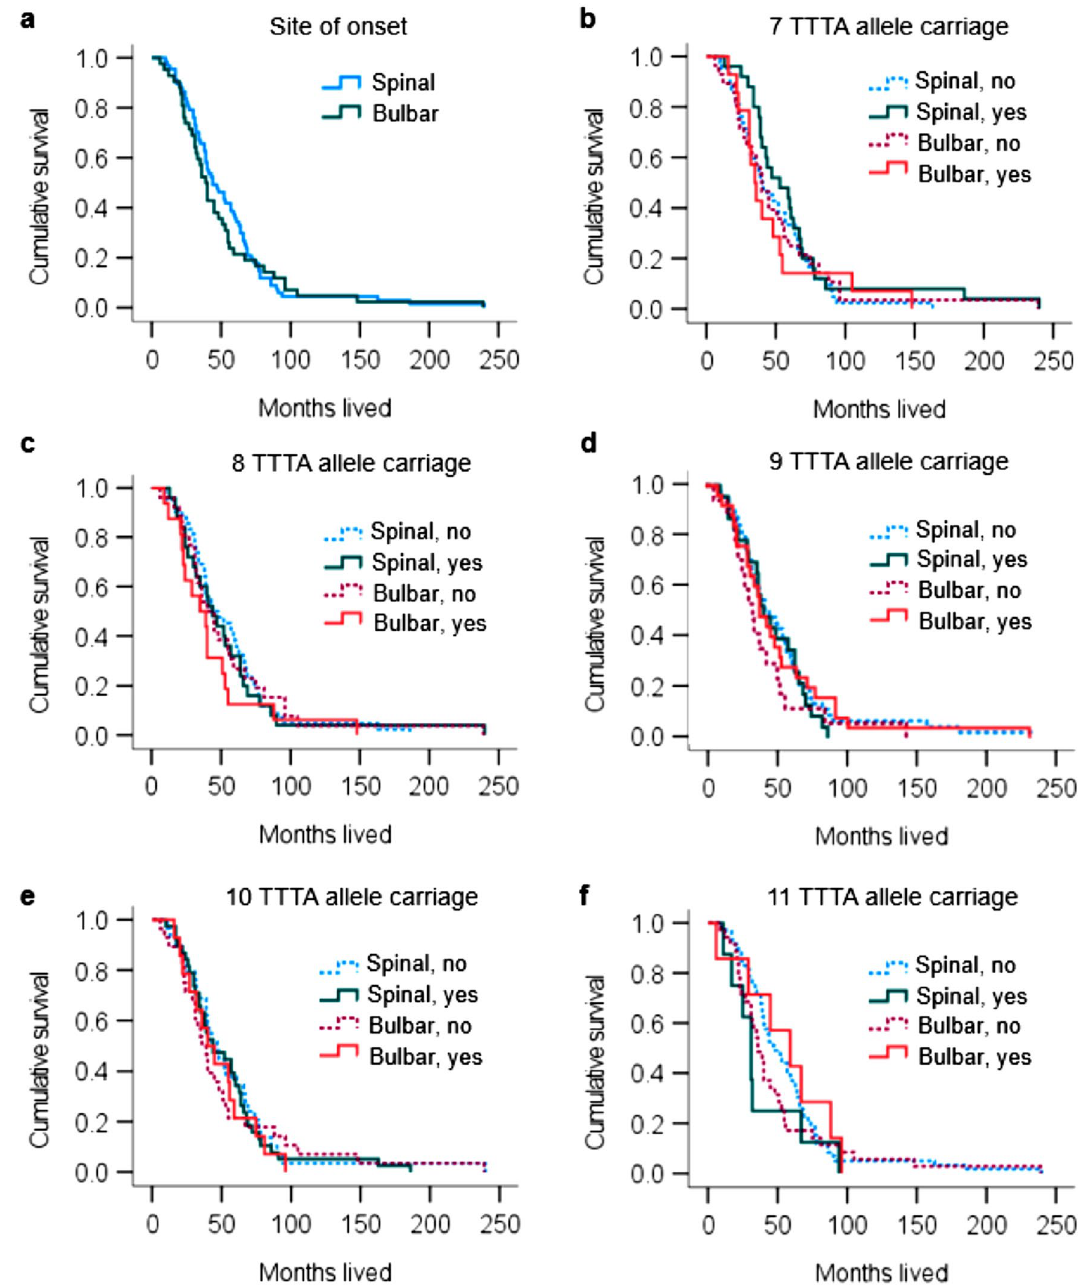
Figure 3. Cumulative survival curves for 138 sALS patients from Duke University ( a ) Survival according to initial site of disease onset. ( b – f ) Survival by presence (yes) or absence (no) of NEFH TTTA alleles and the initial site of sALS disease